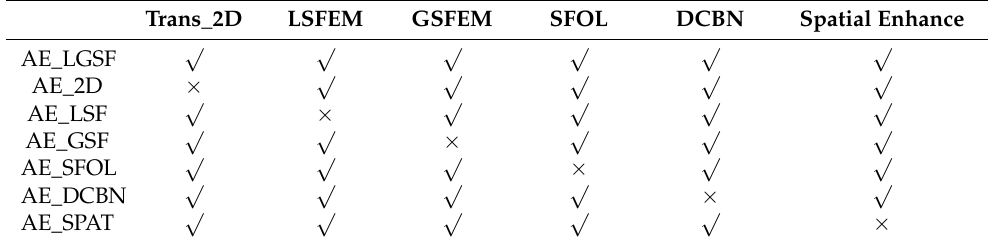
Table 9. The design of ablation experiments.